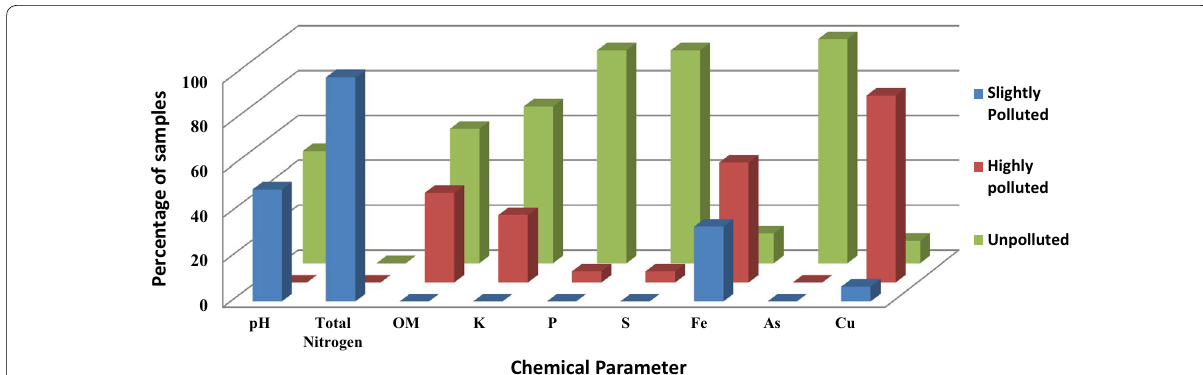
Fig. 7 The percentage of polluted and unpolluted soil